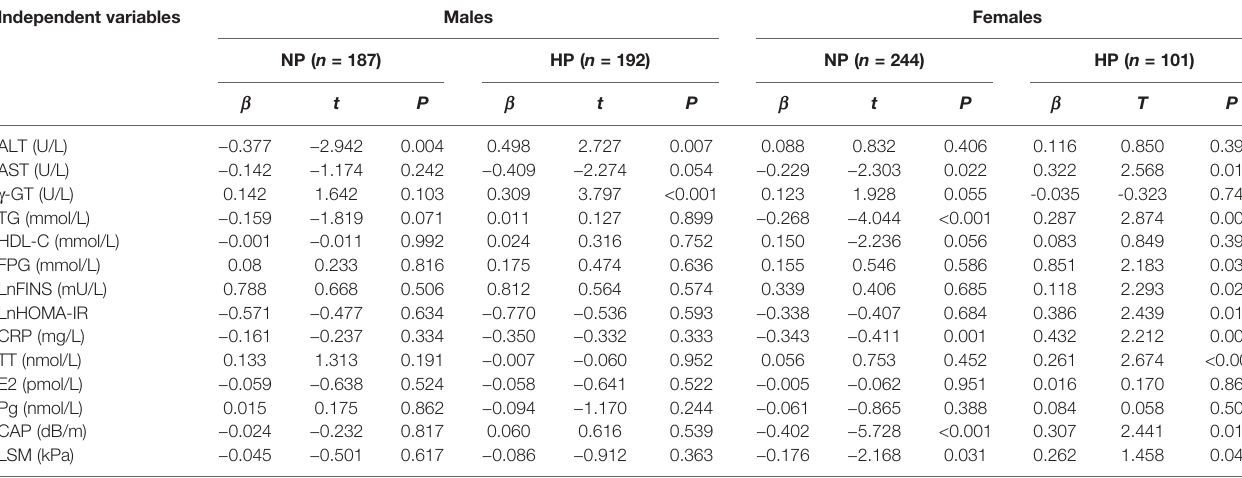
TABLE 2 | Multiple regression analysis showing the relationship between PRL and MAFLD-related risk factors in the NP and HP groups in both genders. Independent variables